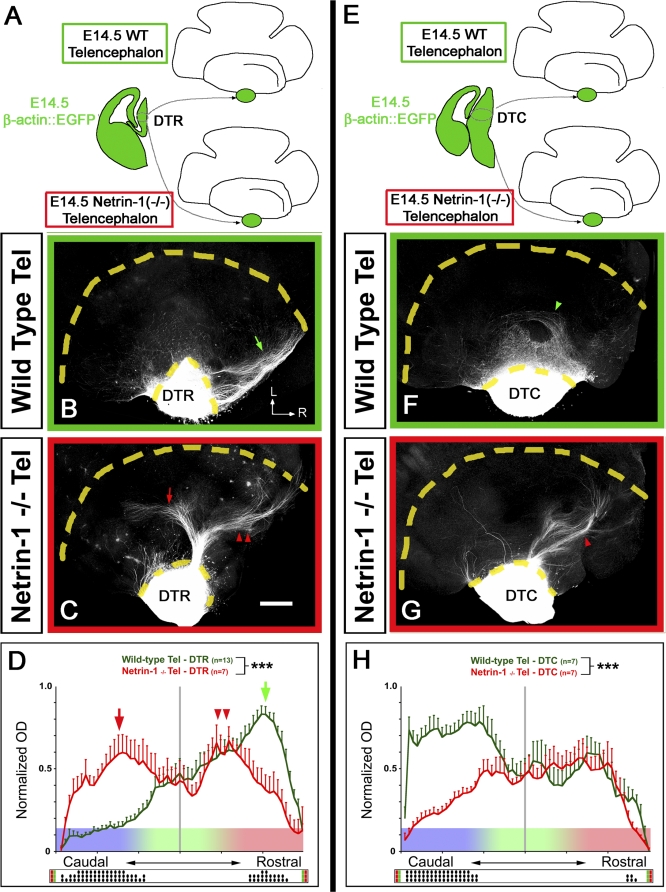
Netrin-1 Is Required in the Ventral Telencephalon to Specify the Topography of Projection of Both Rostral and Caudal Thalamic Axons(A and E) Schema of the experimental paradigm: rostral (DTR; [A–D]) or caudal (DTC; [E–H]) thalamic explants isolated from β-actin::EGFP E14.5 embryos were cocultured with E14.5 whole-mount telencephalon from either wild-type isochronic embryos (B and F) or Netrin-1 knockout isochronic embryos (C and G) in order to test for the requirement of Netrin-1 specifically in the VTel.(B and C) DTR axons show a strong preferential outgrowth in the rostral part of the wild-type VTel (green arrow in [B]). A contingent of wild-type DTR axons grow significantly more caudally in a Netrin-1–deficient VTel (red arrow in [C]), whereas another contingent of TC axons maintains its projection to the rostral part of the VTel (double arrowheads in [C]). L, lateral; R, rostral.(D) Quantification of normalized optical density (OD) of DTR-EGFP axons growing in wild-type (n = 13, green) or Netrin-1 knockout (n = 7, red) telencephalon. Significantly more EGFP-positive axons are growing in the caudal part of the VTel in the Netrin-1 knockout than in the wild-type telencephalon. Triple asterisks (***) indicate p < 0.001, ANOVA one-way test (bins vs. genotype).(F and G) Axons originating from the caudal DTh preferentially grow in the caudal part of wild-type VTel (green arrow in [F]) but grow significantly more rostrally in the Netrin-1–deficient VTel (red arrowhead in [G]).(H) Quantification of normalized optical density (OD) of DTC-EGFP axons growing in wild-type (n = 13, green) or Netrin-1 knockout (n = 7, red) telencephalon. The raster-like dot plots presented under each histogram (D and H) represents the significance of individual bin comparisons between the two experimental conditions according to a Fisher PLSD post hoc test (a single dot [•] indicates p < 0.05; double dots [••] indicate p < 0.01; and triple dots [•••] indicate p < 0.001).Scale bars in (B, C, F, and G) represent 300 μm.